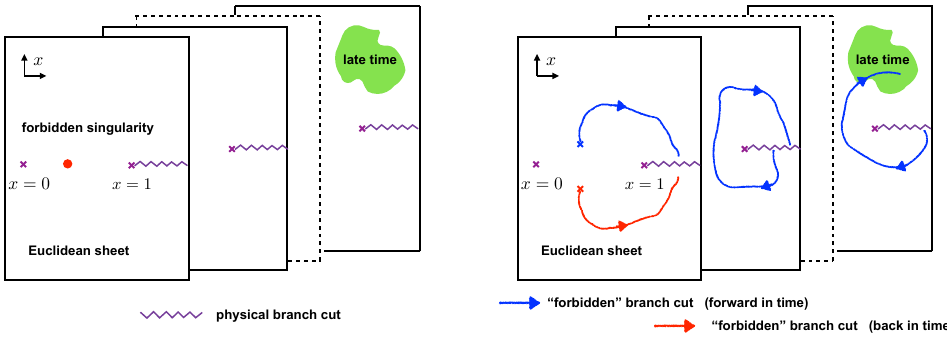
Figure 21 . Left: forbidden singularity separated from the late time. Right: \forbidden" branch-cut can potentially reach the late time.